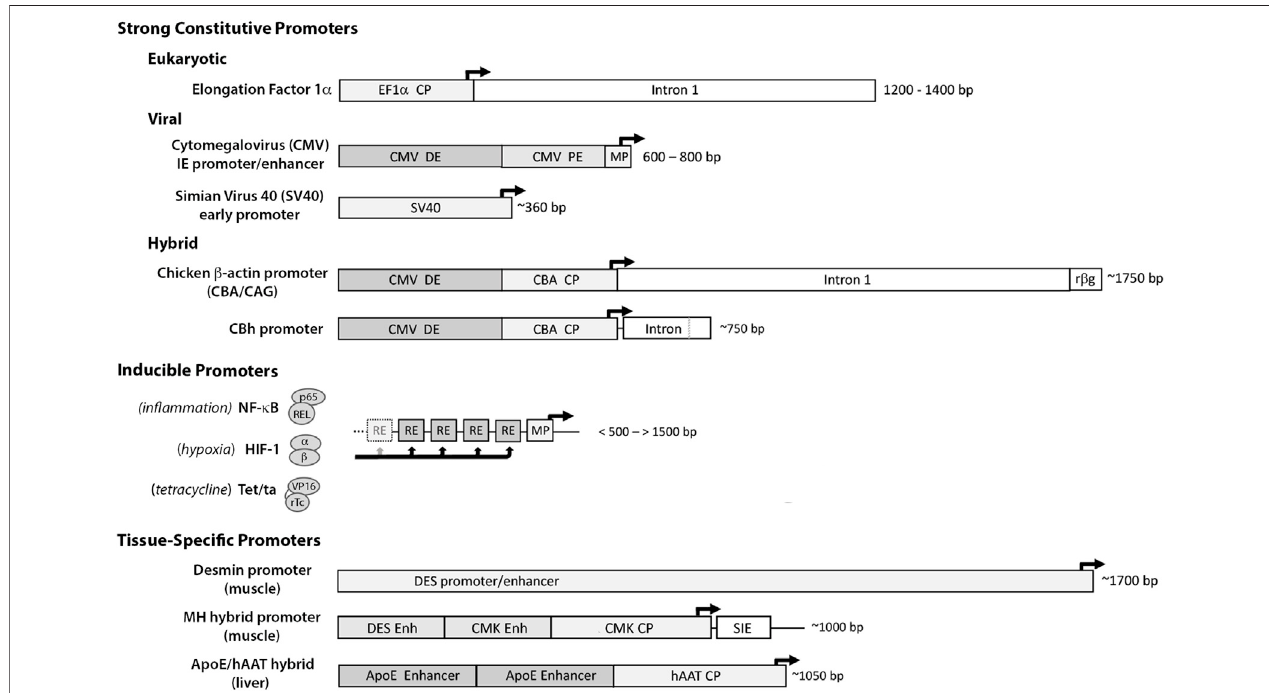
FIGURE 3 | Promoter elements commonly used to drive therapeutic gene expression. Strong Constitutive Promoters: to compensate for limitations with gene delivery,most vector systems employ promoterswith high basalactivationfor continuous high-leveltransgene expression.The diagram illustrates the differences in size andsequencecomponentsamongsomeofthemorewidelyusedconstitutivepromoters.(Thedarkarrowsindicatethetranscriptionstartsite(TSS)anddirectionofRNA synthesis.) 1) the eukaryotic translation elongation factor 1 α (EF1 α ) promoter: a short core promoter (CP) sequence lies upstream of the TSS with additional activation sequences located downstream in intron 1 of the EF1a gene (Wakabayashi-Ito and Nagata, 1994; Gopalkrishnan et al., 1999); 2) the cytomegalovirus (CMV) immediate early promoter/enhancer: composed of a minimal promoter (MP) that signals the TSS with short proximal and distal enhancer elements (PE and DE) immediately upstream (Prösch et al., 1996; Isomura et al., 2004) and 3) the early promoter from Simian Virus 40 (SV40): composed of a small minimal promoter with activation signals located in tandem 21 bp and 72 bp repeat sequences immediately upstream (Gendra et al., 2007). Other strong promoters common in the literature are Hybridsassembledfrom sequence elements ofboth eukaryoticand viralorigin. Among these are1)thechicken β -actinpromoter(CBA/CAG) comprised oftheCMV distalenhancer(DE)positionedupstreamoftheCBAcorepromoter,followedbythesplicedonorandenhancerelementsfromCBAintron1fusedtothespliceacceptor site of exon 3 of the rabbit b-globin gene (r β g) (Xu et al., 2001; You et al., 2010), and 2) the derivative CBh promoter composed of the CMV DE and CBA core promoter, with a hybrid intron immediately downstream composed of the splice donor site from CBA intron 1 fused to the splice acceptor site from minute virus of mice (MVM) VP intron (Gray et al., 2011). As each can provide high-level expression in the proper contexts, promoter selection is heavily in fl uenced by size- of both the promoter and transgene and available space within vector. Inducible Promoters: for certain applications where conditional expression is desired, a wide range of synthetic inducible promoter systems are commercially available, or can be readily constructed/synthesized using the minimal CMV promoter as the transcription start site linked to an upstreamarrayofupto30response/recognitionelements(REs)(Edeetal.,2016)forpotenttranscriptionfactor(s)inducedbyaparticularchange(s)ingrowthconditions, such as NF-kB (in fl ammation) or HIF1 (hypoxia) (Shibata et al., 2000). Alternatively transgene expression can be induced externally by the presence of a chemical agent, such as tetracycline which enables a Tet-binding transactivator (Tet/ta) to bind and interact with the TetO cis element (Loew et al., 2010). Tissue Speci fi c Promoters: to